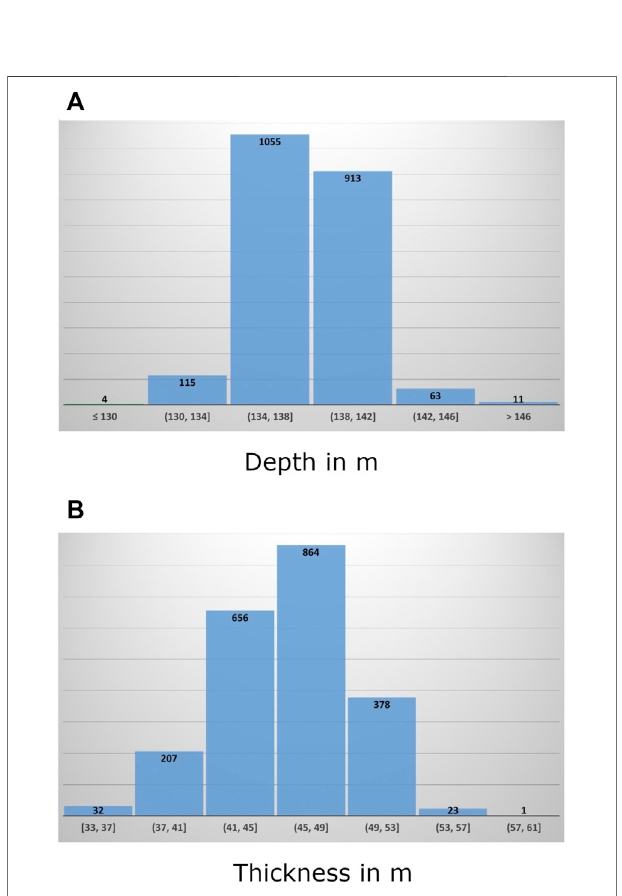
FIGURE 12 | Southern contour histogram: (A) Depths of pinchout points; (B) Sediment thicknesses above the pinchout contour.